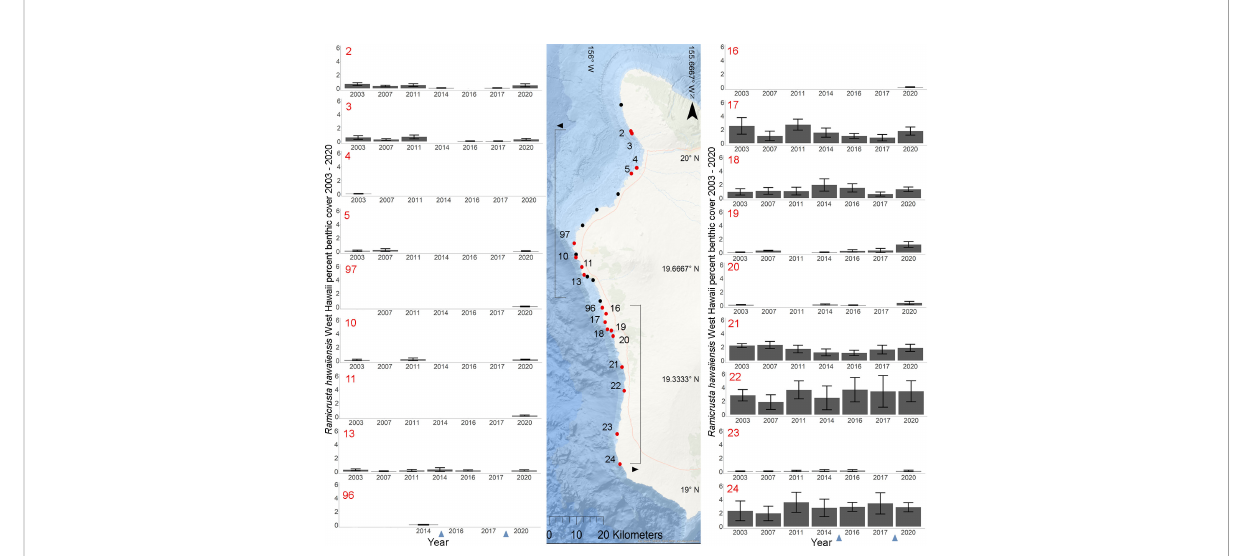
FIGURE 5 Geographic and temporal distribution of percent benthic cover of Ramicrusta. Map of the 26 DAR-WHAP sites in west Hawai ’ i (center), and 18 graphs of temporal benthic cover at sites where Ramicrusta was present (left and right). Ramicrusta was present at sites shown in red, but absent at sites shown in black. Individual site percent cover values for Ramicrusta are ordered by latitude with standard error bars with northern (bracketed with arrow pointing left) and southern (bracketed with arrow pointing right) sites. Only sites that had detectable Ramicrusta were plotted. The absence of bars indicates that no Ramicrusta was observed at that site in that year. Note sites 97 and 96 are plotted in this fi gure but not included in statistical analysis due to missing survey years. The absence of years in the x axis indicates that no benthic surveys were conducted at that site in that year. Blue arrows on the x axis indicate years with marine heat waves.